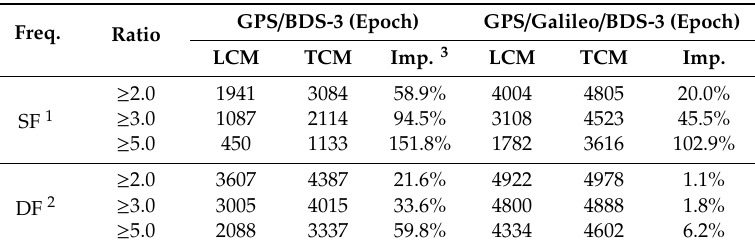
Table 4. Statistics of ratio values for GPS / BDS-3 and GPS / Galileo / BDS-3 solutions with 10 ◦ elevation cut-off angle. Number of epochs 5041.